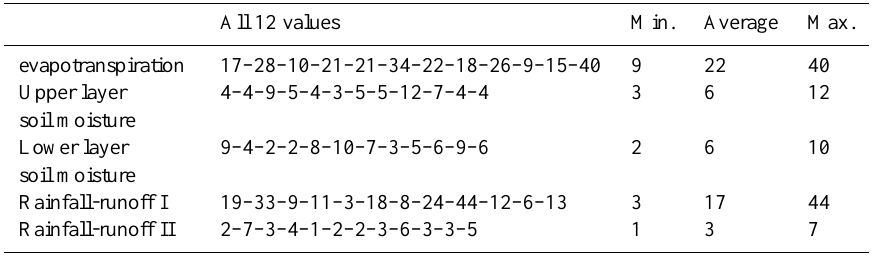
Table 6. The optimum number of nearest neighbors (K-nn) of the 12 models in each case study. All 12 values Min. Max.